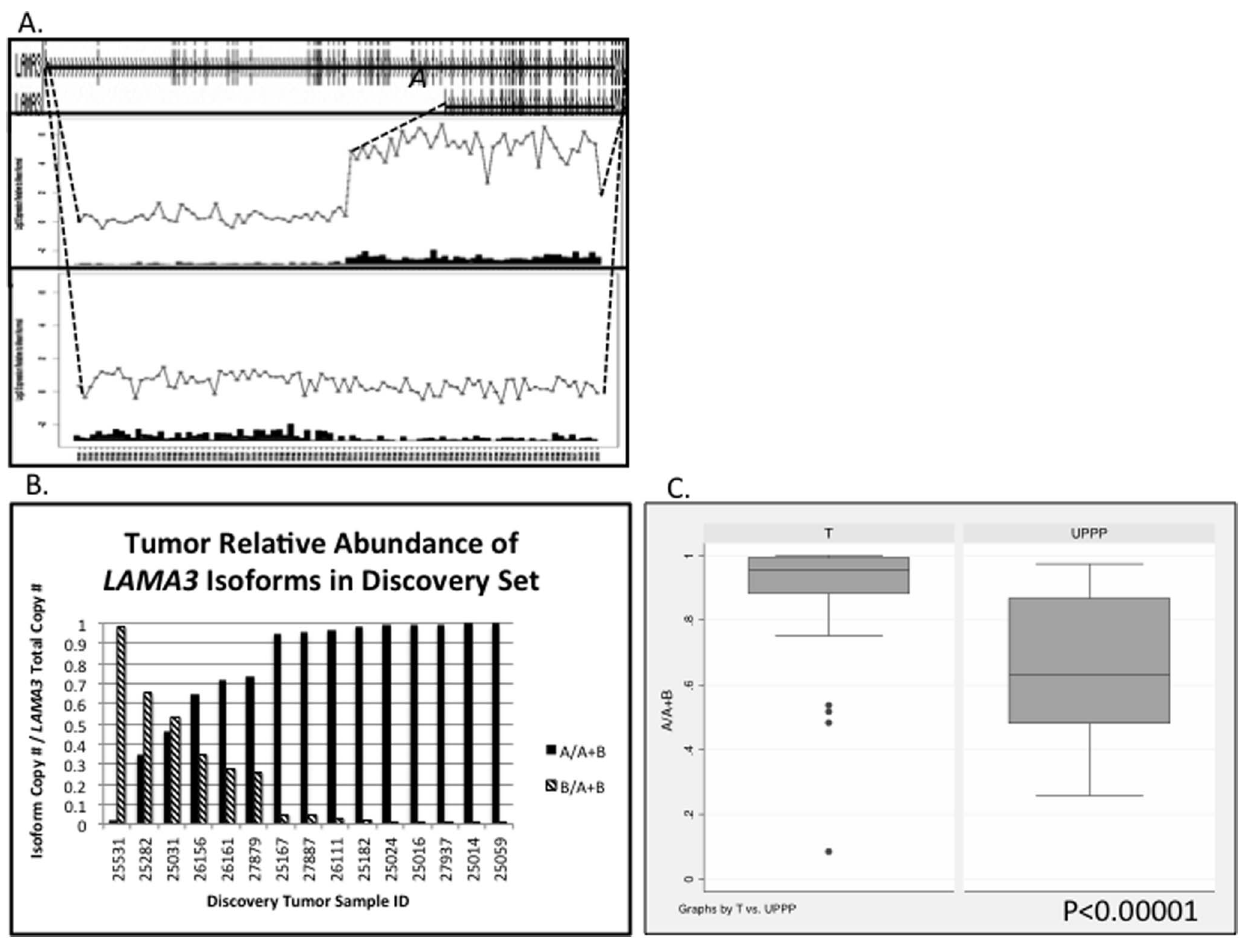
Figure 4. Splice variants of LAMA3 demonstrated in exon array analysis (A) and quantitative RT-PCR validation (B and C). A, Example of discovery HNSCC primary tumor samples (25059 and 25282) demonstrating dominant expression of LAMA3A and LAMA3B isoforms, respectively. Uppermost box displays all exons for both isoforms of LAMA3 . Middle and lower boxes display exon-specific array probesets along horizontal axis, and probeset signal relative to normal (0) on the vertical axis, log 2 scale . For each probeset, the inset histograms display the number of standard deviations from the mean probeset signal in UPPP samples, that the probeset signal deviates in each individual tumor. B, Splice index calculations [Absolute Copy # of LAMA3A isoform / ( LAMA3A + LAMA3B )] in 15 discovery tumor samples. C, Comparison of mean splicing index for LAMA3 isoforms in an independent validation set of 47 HNSCC tumors vs. 19 UPPP samples, two-tailed Student’s t test, p , 0.0001 .